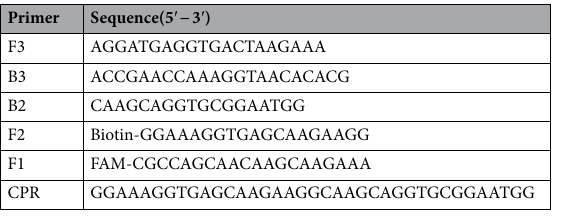
Table 4. Primer and probe